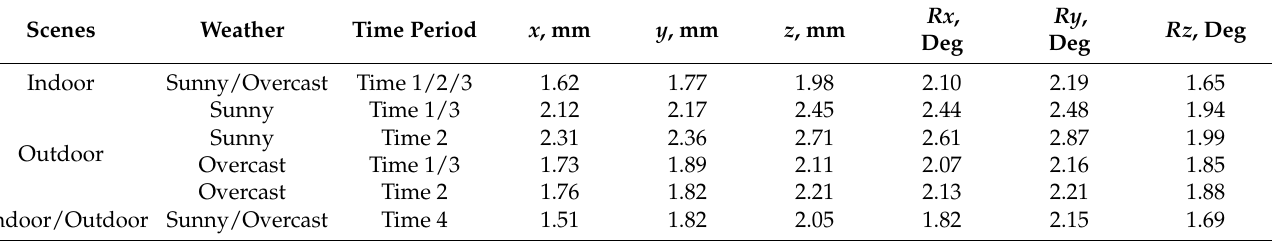
Table 3. Pose solution errors in the search